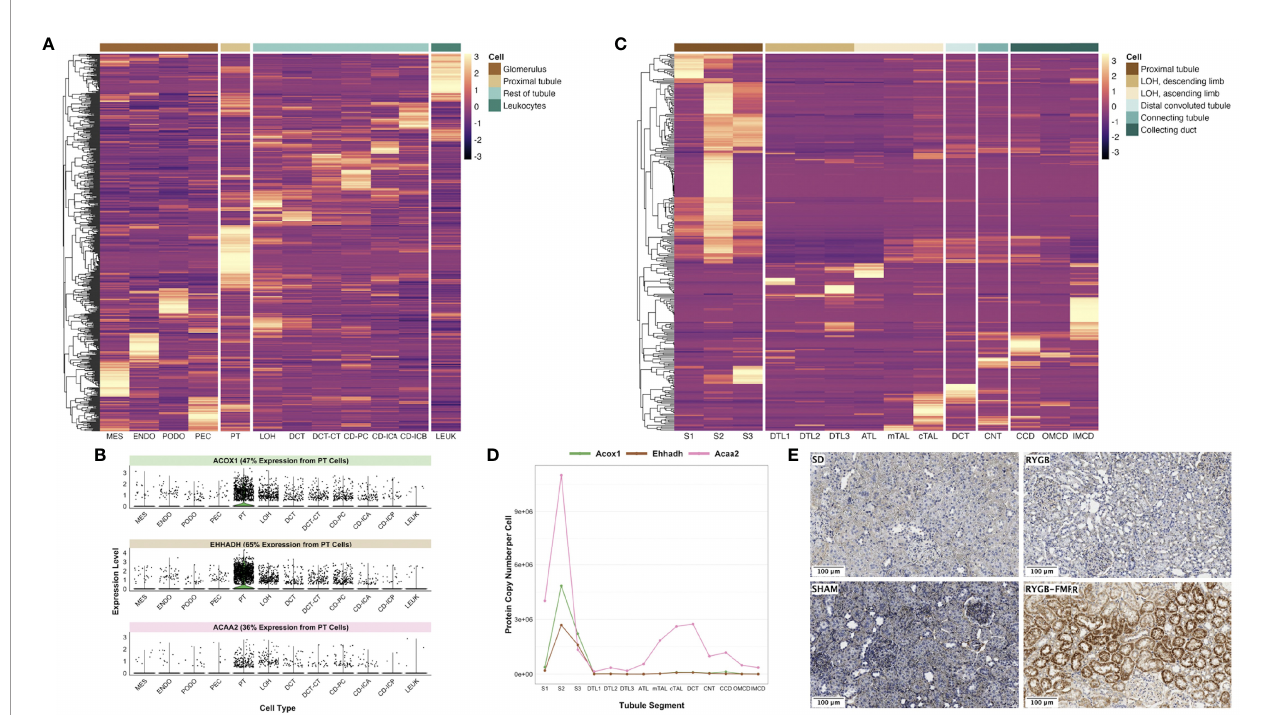
FIGURE 3 | In silico deconvolution of the predicted cellular source of transcripts differentially expressed between the RYGB-FMRR and RYGB groups. (A) Transcripts identi fi ed in the RYGB-FMRR versus RYGB differential expression analysis were intersected with a human diabetic kidney single-nucleus RNA- sequencing dataset (56). Transcript expression levels in the human diabetic kidney, averaged across cell types by the Seurat function ‘ AverageExpression ’ and subsequently centred and scaled by row, are plotted on the heatmap. Heatmap rows display the differentially regulated transcripts whilst each column represents 1 of 12 identi fi ed renal cell types. Cell groupings of individual cell types in the heatmap columns are indicated in the legend key. An increasingly light colour in a speci fi c cell type re fl ects an increased relative expression therein relative to other cell types. (B) Violin plots of cell-speci fi c expression in the human diabetic kidney of three PPAR a -responsive transcripts upregulated by RYGB-FMRR. Kidney cell types are presented on the x-axis with relative transcript expression levels in the human diabetic kidney on the y-axis. Each dot represents a single cell in the human diabetic kidney. The proportion of expression of each transcript by proximal tubular cells as a proportion of all cells identi fi ed in the single-nucleus RNA-sequencing dataset is indicated. (C) Transcripts identi fi ed in the RYGB-FMRR versus RYGB differential expression analysis were intersected with a proteomics dataset of microdissected Sprague Dawley rat kidney tubules (https://esbl.nhlbi.nih.gov/KTEA/) (58). Protein expression (copy number per cell) in rat tubular epithelial cells is plotted on the heatmap, after centering and scaling by row. Heatmap rows display the differentially regulated transcripts between RYGB-FMRR and RYGB whilst each column represents 1 of 14 rat tubular epithelial cell types. Cell groupings of individual cell types in the heatmap columns are indicated in the legend key. An increasingly light colour in a speci fi c cell type re fl ects an increased relative expression therein relative to other cell types. (D) Line plots of cell-speci fi c expression in rat tubular epithelial cells of three PPAR a -responsive transcripts upregulated by RYGB-FMRR. Tubular epithelial cell types are presented on the x-axis with protein expression (copy number per cell) in rat tubular epithelial cells on the y-axis. (E) Representative images (20x, scale bar 100µm) of kidney immunohistochemical ACOX1 staining across the four experimental groups, validating the proximal tubular localisation of ACOX1 as well as its induction in rats treated with RYGB-FMRR. ACAA2, acetyl-coenzyme A acyltransferase 2; ACOX1, acyl-CoA oxidase 1; ATL, ascending thin limb of Henle ’ s loop; CCD, cortical collecting duct; CD-ICA, collecting duct-intercalated cell type A; CD-ICB, collecting duct-intercalated cell type B; CD-PC, collecting duct- principal cell; CNT, connecting tubule; cTAL, cortical thick ascending limb; DCT, distal convoluted tubule; DCT-CT, distal convoluted tubule-connecting tubule; DTL1, descending thin limb of Henle ’ s loop, short-loop; DTL2, descending thin limb of Henle ’ s loop, long-loop, outer medulla; DTL3, descending thin limb of Henle ’ s loop, long-loop, inner medulla; ENDO, endothelial cell; EHHADH, enoyl-CoA hydratase and 3-hydroxyacyl CoA dehydrogenase; IMCD, inner medullary collecting duct; LEUK, leukocytes; LOH, loop of Henle; MES, mesangial cell; mTAL, medullary thick ascending limb; OMCD, outer medullary collecting duct; PEC, parietal epithelial cell; PODO, podocyte; PPAR a , peroxisome proliferator-activated receptor-alpha; PT, proximal tubule; RYGB, Roux-en-Y gastric bypass; RYGB-FMRR, Roux-en-Y gastric bypass plus feno fi brate, metformin, ramipril, and rosuvastatin; S1, S1 region of proximal tubule; S2, S2 region of proximal tubule; S3, S3 region of proximal tubule; SD, Sprague Dawley; SHAM, sham surgery